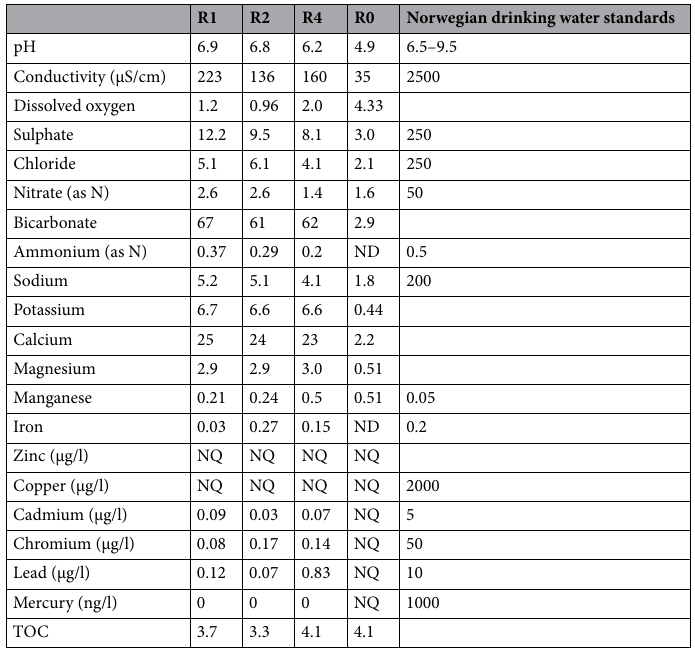
Table 2. Comparison between the current groundwater quality under the stabilised landfill phase versus the Norwegian drinking water standards and the local background groundwater quality. Values are the means for samples collected in 2018 and 2019. All units are in mg/l, otherwise indicated. All values for mercury were below the limit of detection but reported as zero. Values for nitrate and ammonium in the Norwegian drinking water standards are in mg/l. ND not detected (below the limit of detection); NQ not